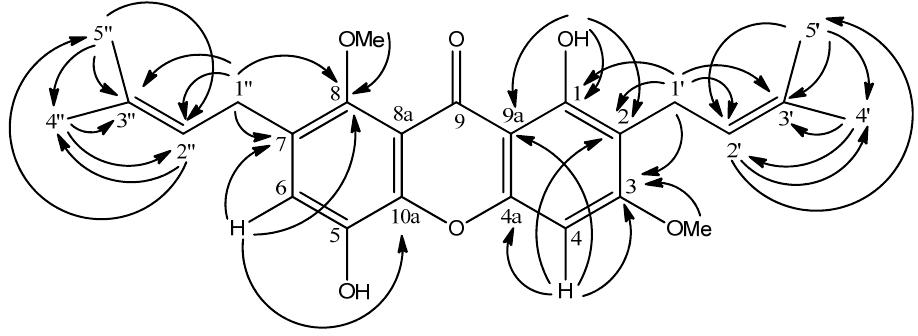
Figure 2. HMBC 2 J and 3 J correlations between 1 H and 13 C in 1